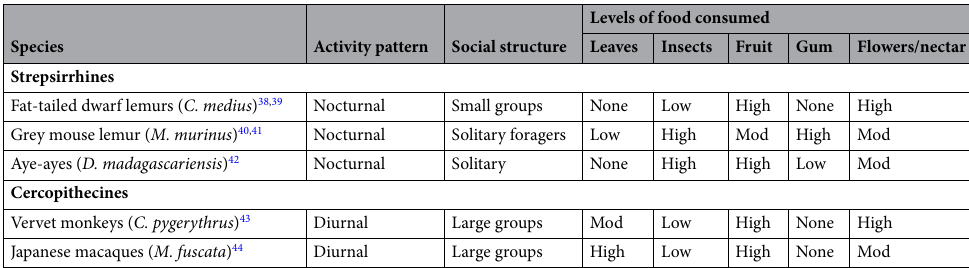
Table 1. Socio-ecological traits of the five primate species included in our